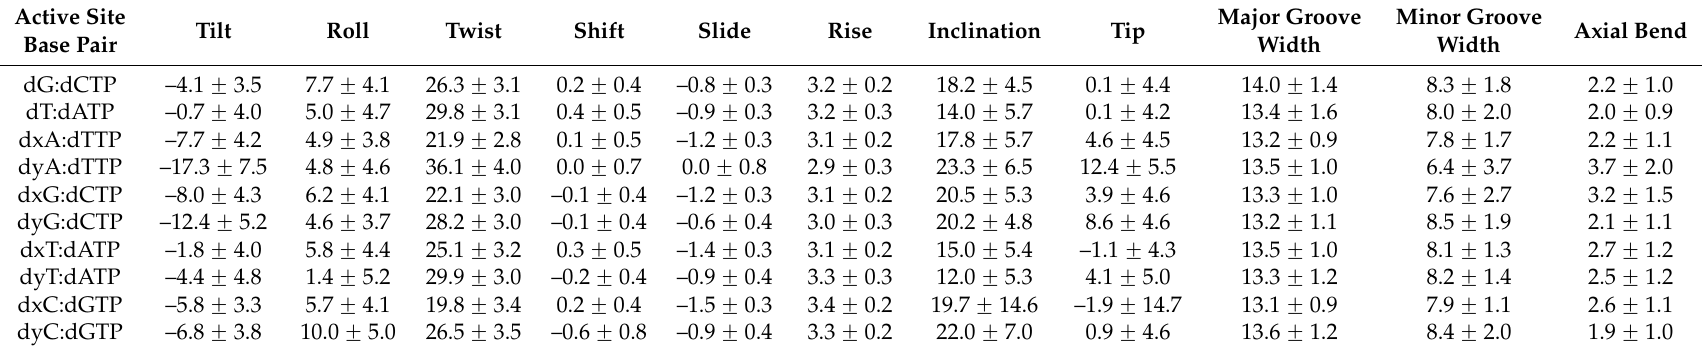
Table 4. Averages and standard deviations of the base-step and helical parameters during 40 ns MD simulations of the Dpo4 ternary complex for the replication of a DNA, xDNA or yDNA base a,b